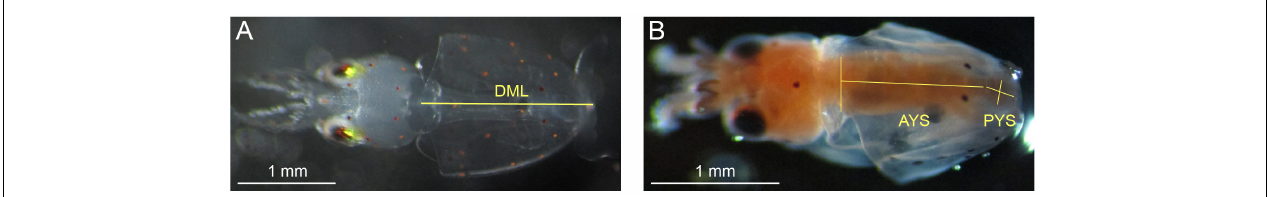
FIGURE 1 | Morphometrics measured on Doryteuthis pealeii paralarvae through microscope imagery. (A) Dorsal mantle length (DML; the superimposed yellow line) of an anesthetized paralarvae. (B) Squid paralarvae were fixed and stained with oil red O for measurement of YV. The length and width of both the anterior yolk sac (AYS), which was modeled as either a cone or cylinder (cone, in this case), and the posterior yolk sac (PYS), which was modeled as an ellipsoid were measured (superimposed yellow lines). Each image has a unique 1 mm white scale bar at bottom left.